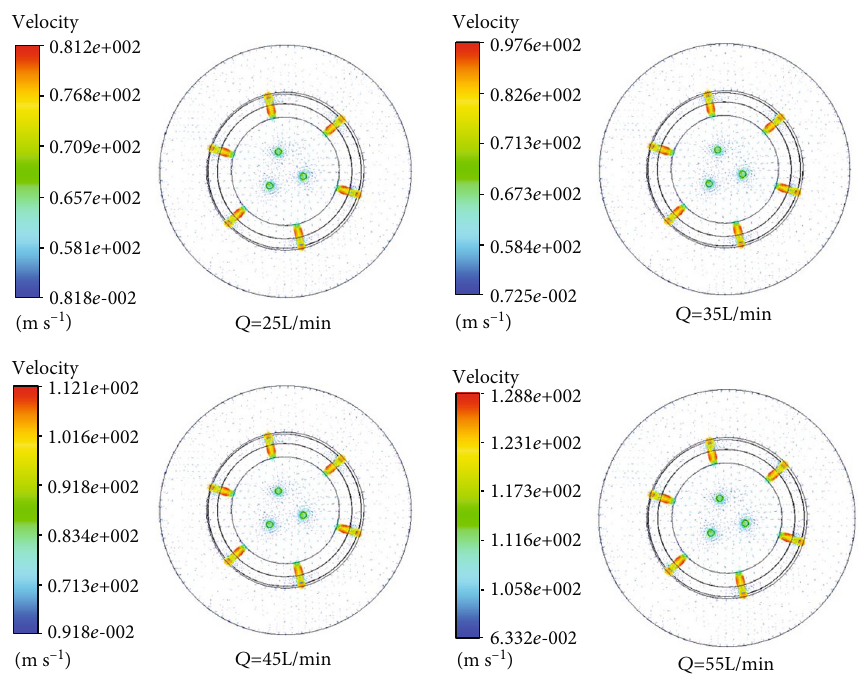
Figure 5: The jet velocity distributions of forward ori fi ce under di ff erent inlet displacement.